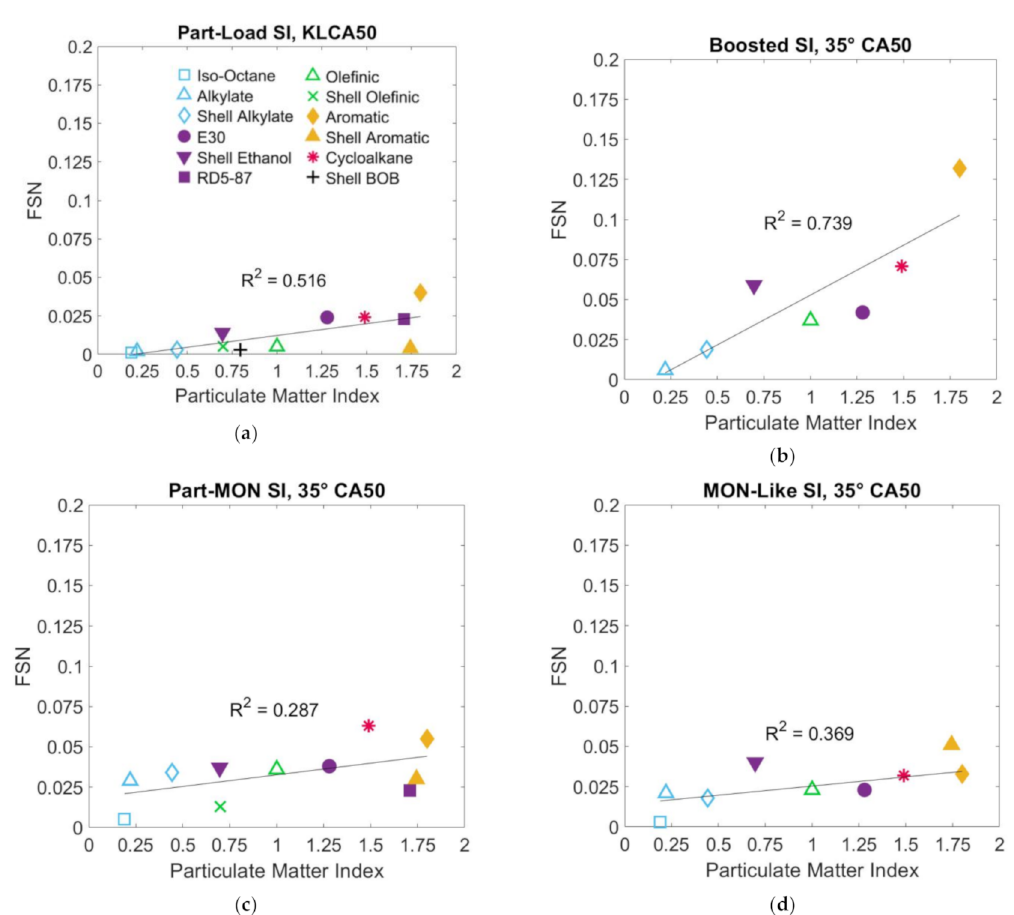
Figure A1. Octane index for fuels under ( a ) part-load SI, ( b ) boosted SI, ( c ) part-MON SI, ( d ) MON-like SI